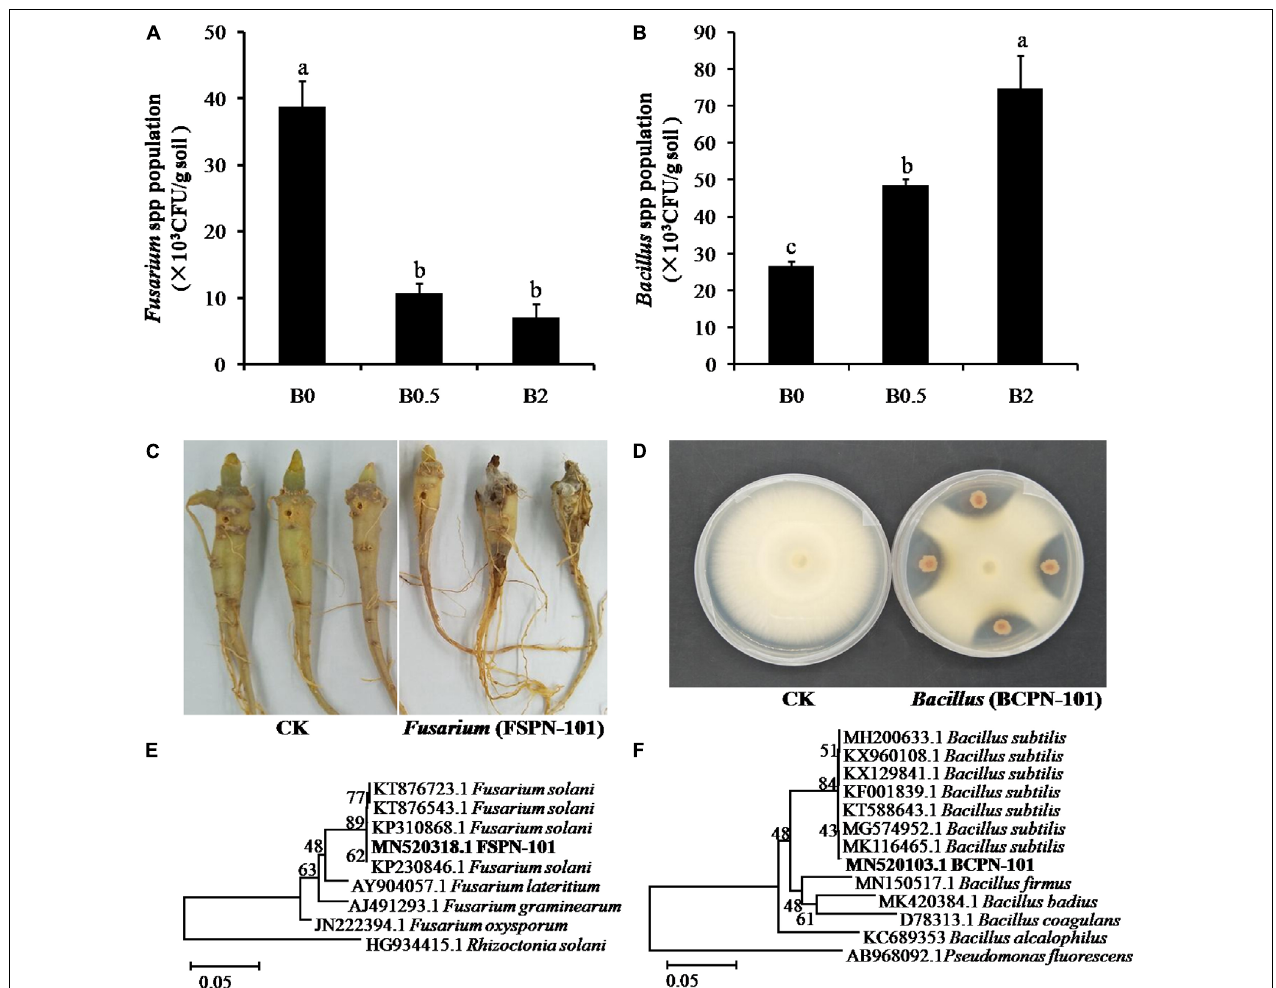
FIGURE 6 | The isolation and identification of pathogen Fusarium and antagonistic bacteria Bacillus. Panel (A) shows the number of potential pathogen Fusarium isolated from different soil; (B) shows the number of potential beneficial bacteria Bacillus isolated from different soil; (C) shows the symptoms of sanqi root rot after inoculating Fusarium strain FSPN-101; (D) shows the antagonistic activity against Fusarium solani of Bacillus strain BCPN-10; (E) shows hierarchical clustering of ITS genes of the F. solani strain FSPN-101; (F) shows hierarchical clustering of 16S rDNA genes of the Bacillus subtilis strain BCPN-10. Different letters indicate significant differences among the treatments by Duncan’s multiple range tests ( p < 0.05; n = 4).